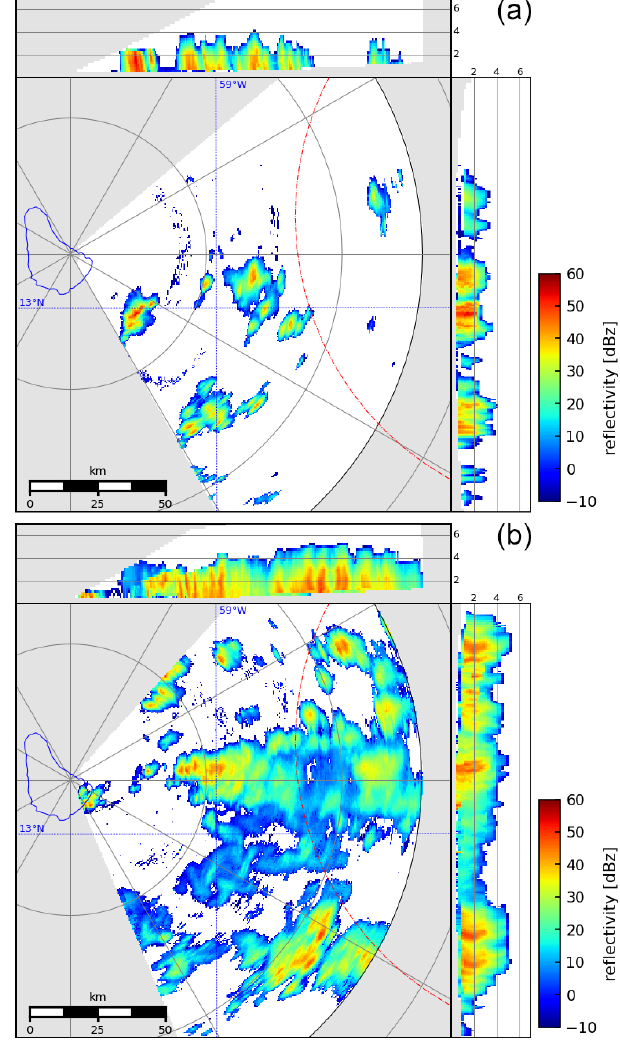
Figure 8. Maximum display (for details see text) of reflectivity. Red dot-dashed line shows HALO circle pattern. Heights of side projections are in kilometers (km). (a) 5 February 2020, 12:03UTC; (b) 11 February 2020 07:27UTC.